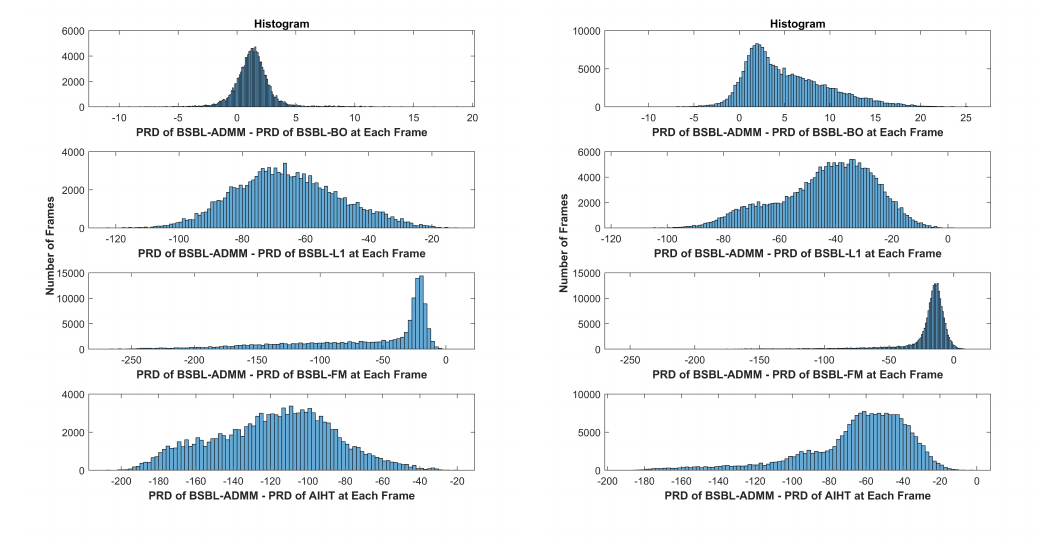
Figure 5. Histogram of the difference between the PRD of BSBL-ADMM and the PRD of the other four algorithms at each frame over all the recordings in MIT-BIH Arrhythmia Database and MIT-BIH Long-Term ECG Database at the CR of 60%. It can be seen that the PRD of BSBL-ADMM is significantly smaller than BSBL-L1, BSBL-FM and AIHT. In addition, the PRD of BSBL-ADMM is larger than BSBL-BO, but the difference is relatively small and the recovery accuracy of the proposed BSBL-ADMM and BSBL-BO is very